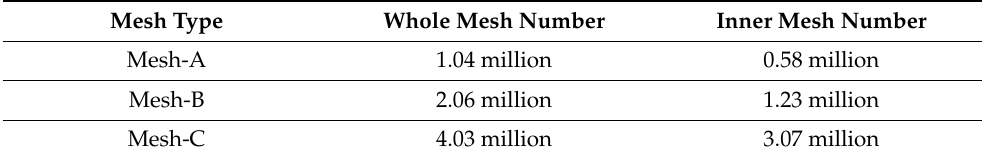
Table 4. Three types of mesh size.